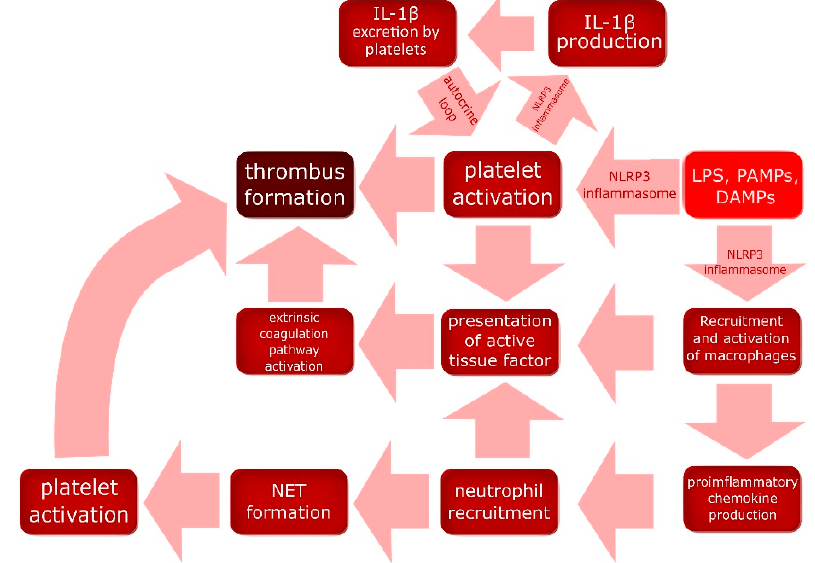
Figure 3. NLRP3 inflammasome’s role in immunothrombosis. NLRP3 inflammasome activated by DAMPs and PAMPs activates platelets and leukocytes which in turn have the potential to activate the extrinsic pathway of the coagulation cascade, which leads to thrombus formation. Platelet activation is further enhanced though an IL-1 β -mediated autocrine-paracrine loop. DAMPs—damage-associated molecular patterns; PAMPs—pathogen-associated molecular patterns; LPS—lipopolysaccharide; NET—neutrophil extracellular trap.